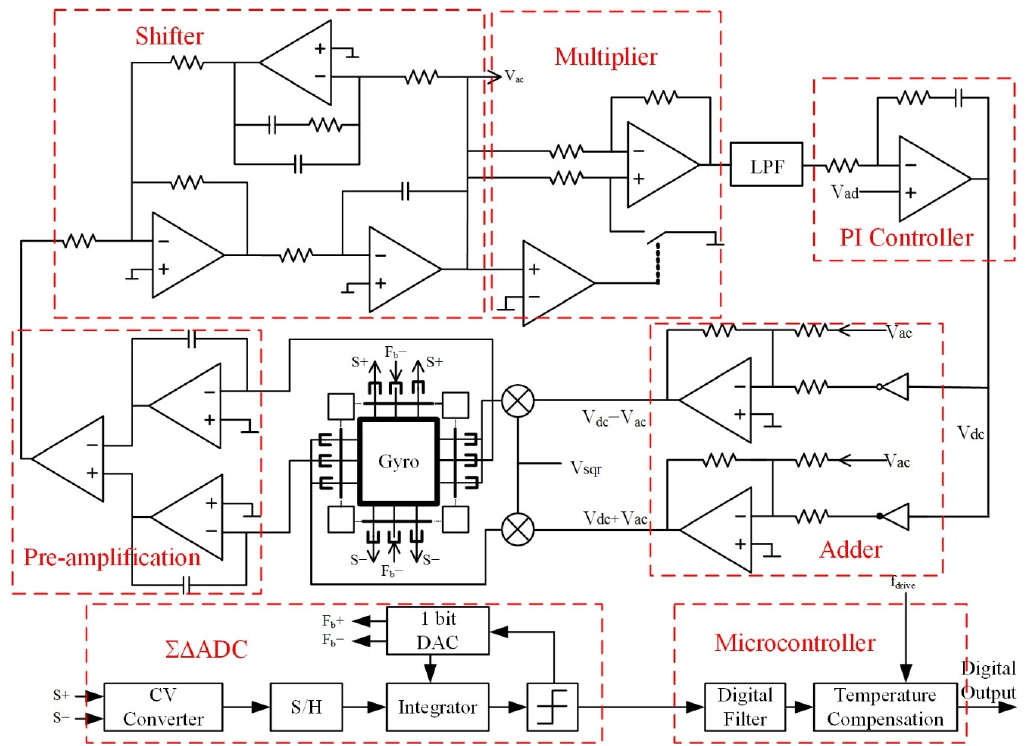
Figure 6. Overall design of silicon gyroscope interface circuit.